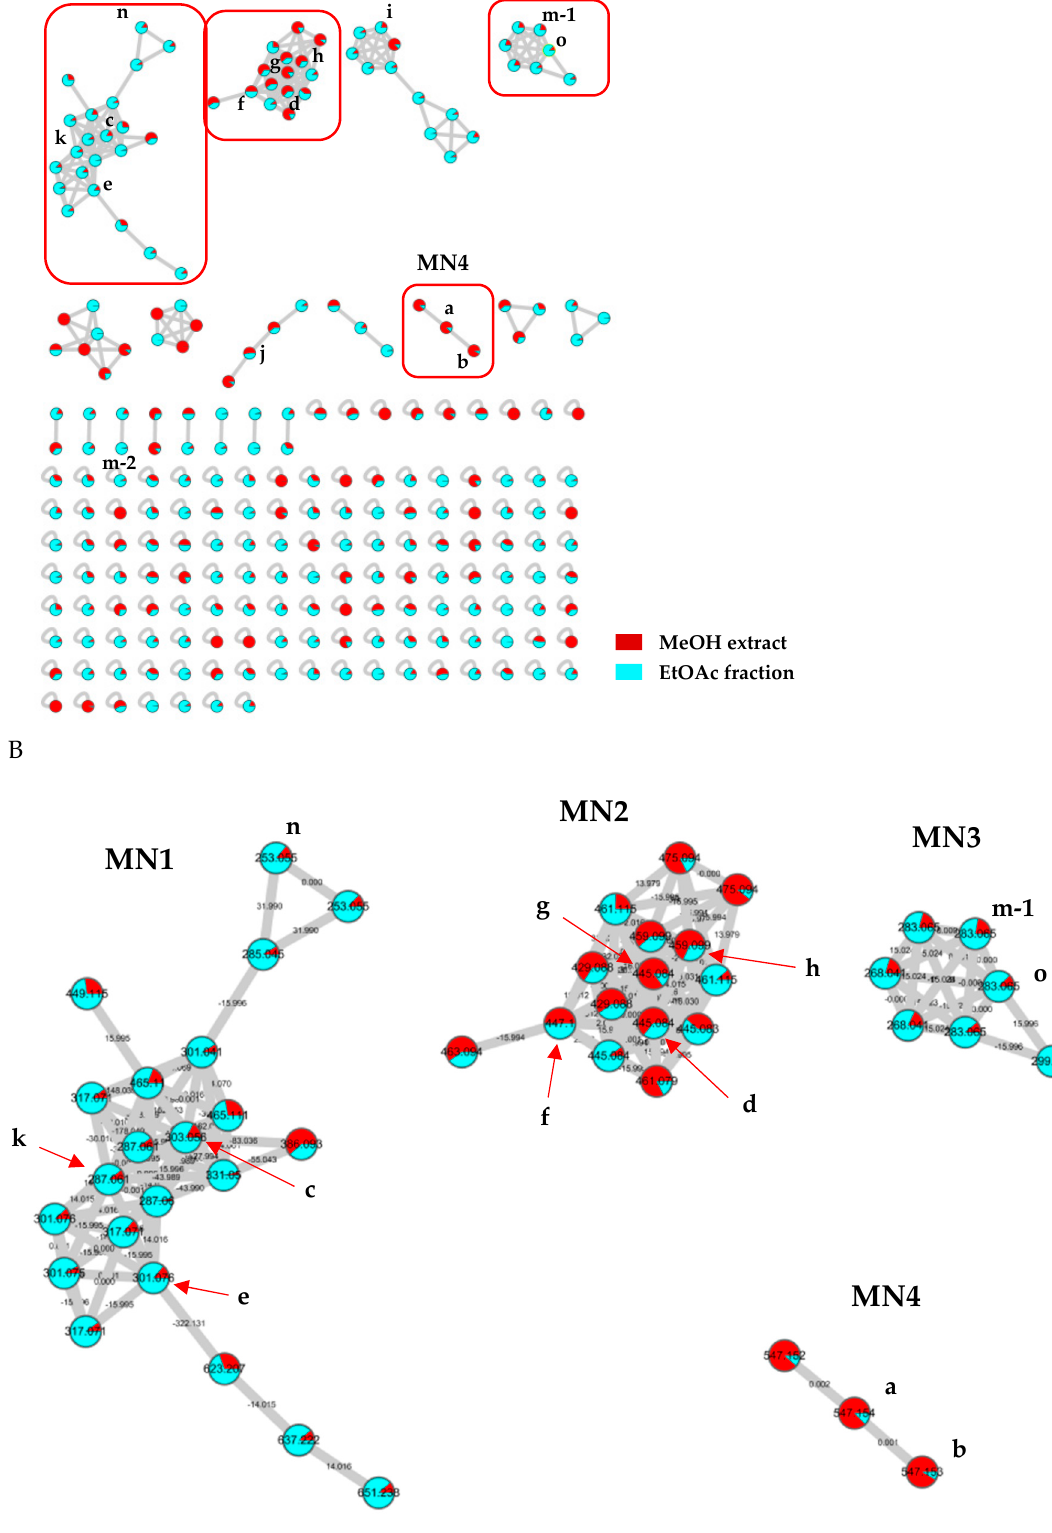
Figure 3. Dereplication using molecular networking. ( A ) Whole molecular network of S. baicalensis extract and EtOAc fraction; ( B ) identified peaks and isolated compounds ( a – h , k and m – o ) and their clustering.